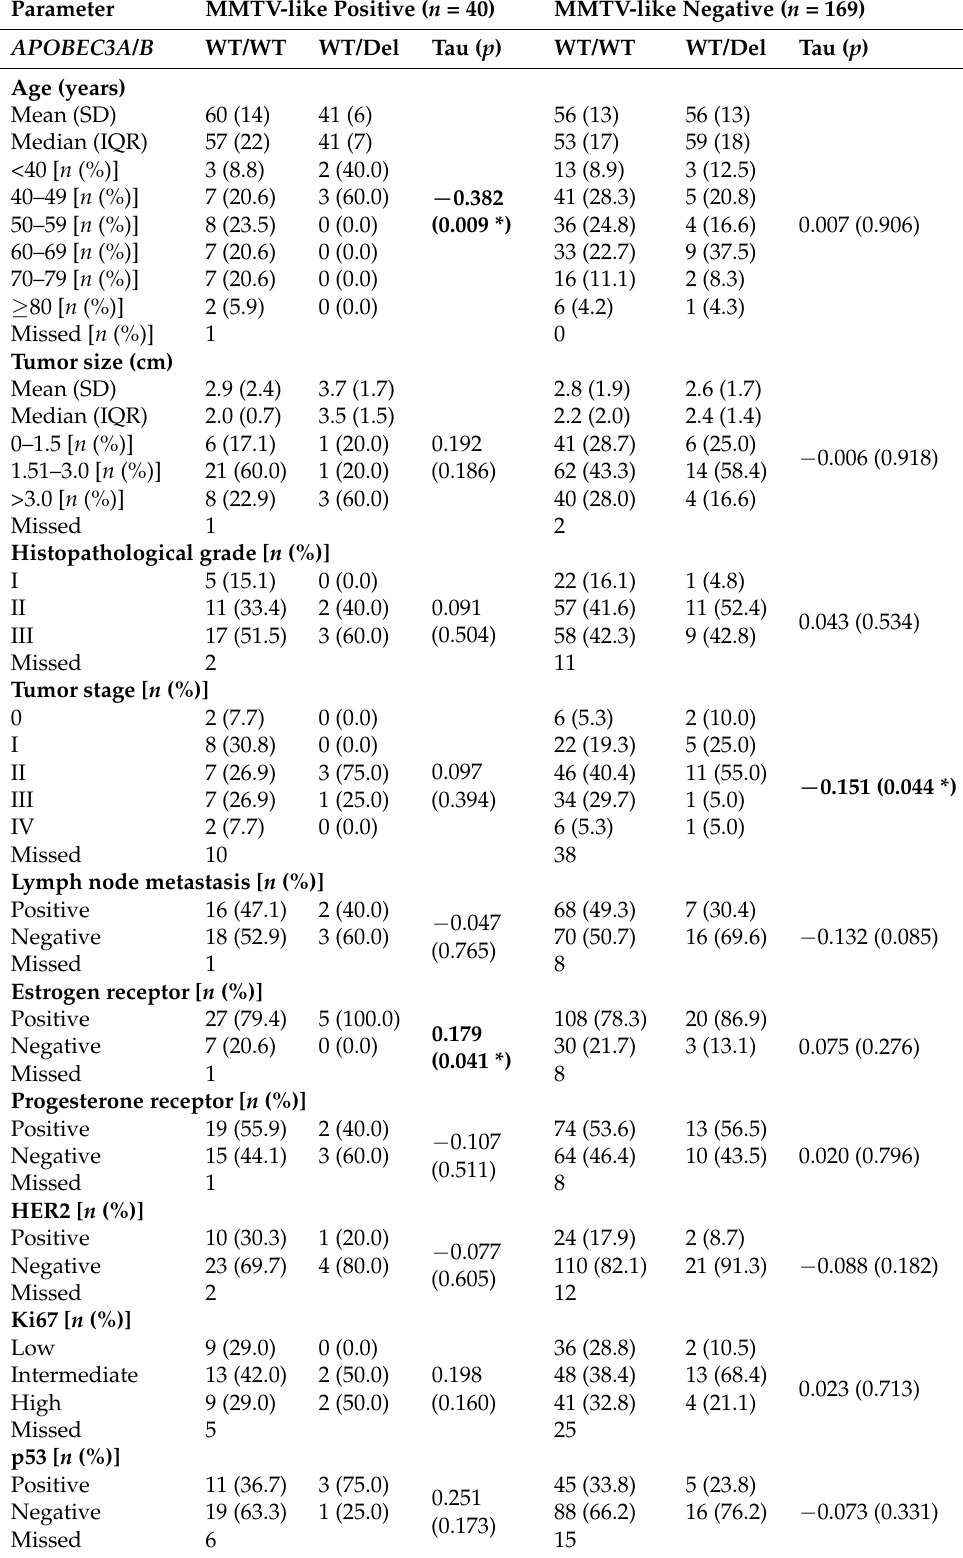
Table 2. Data on the clinicopathological characteristics of the